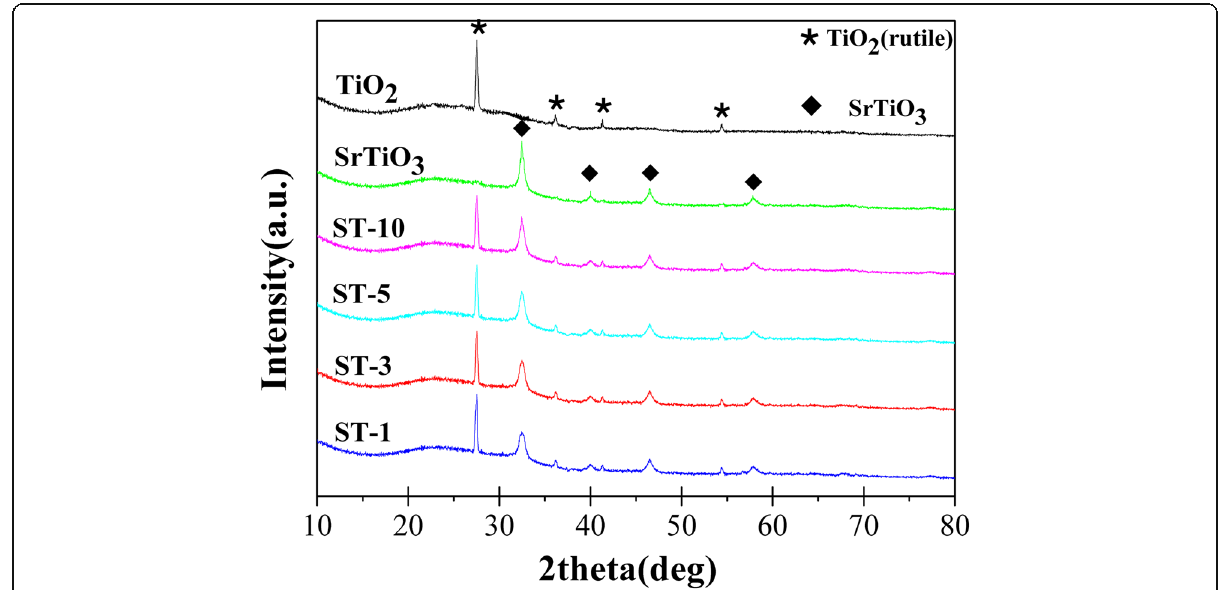
Fig. 2 XRD patterns of the bare TiO 2 (Rutile), bare SrTiO 3 , ST-10, ST-5, ST-3 and